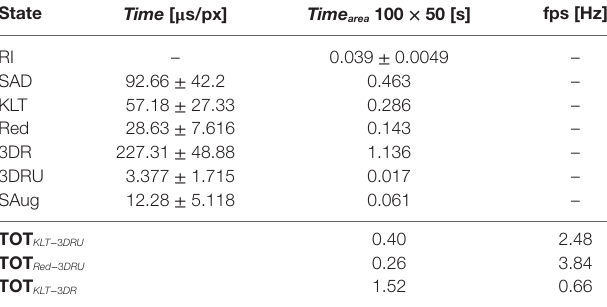
TaBle 4 | Performance evaluation: computational time of each state-of-the-art machine.